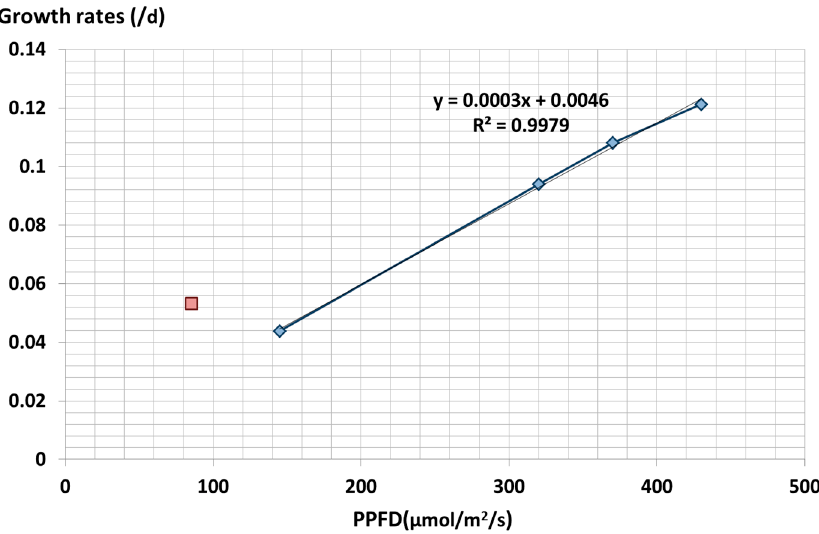
Figure 8. Spirulina growth rates with respect to PPFD. The correlation (blue diamonds) does not include the first point at 85 µmol/m 2 /s (red square). No replicate.